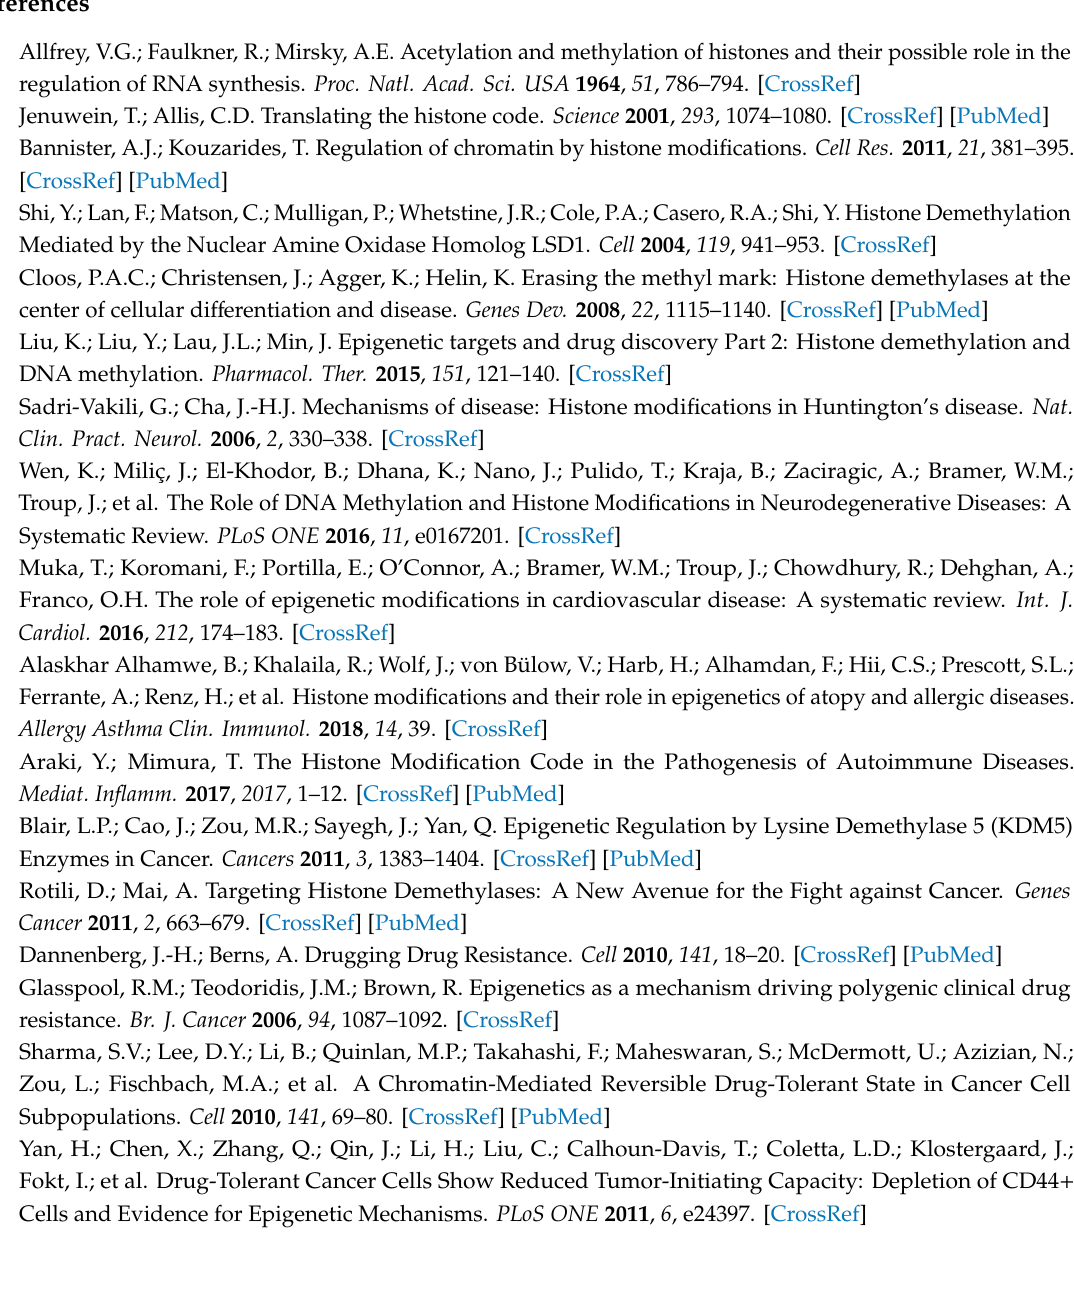
assay, Table S1: Statistical evaluation of the expression di ff erences between glioblastoma and normal brain datasets for each A ff ymetrix